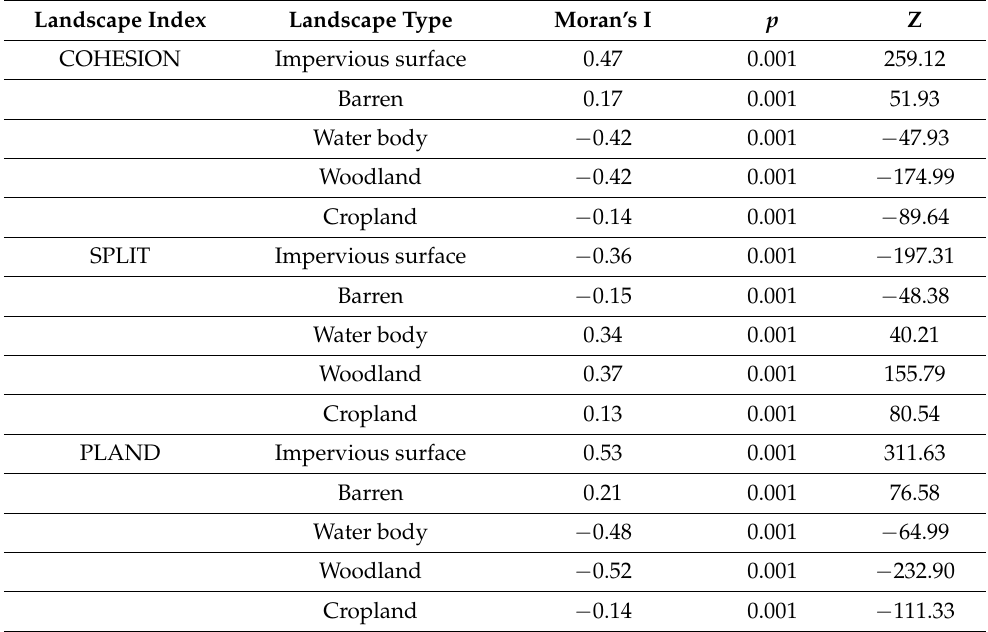
Table 2. The correlation between the landscape index and